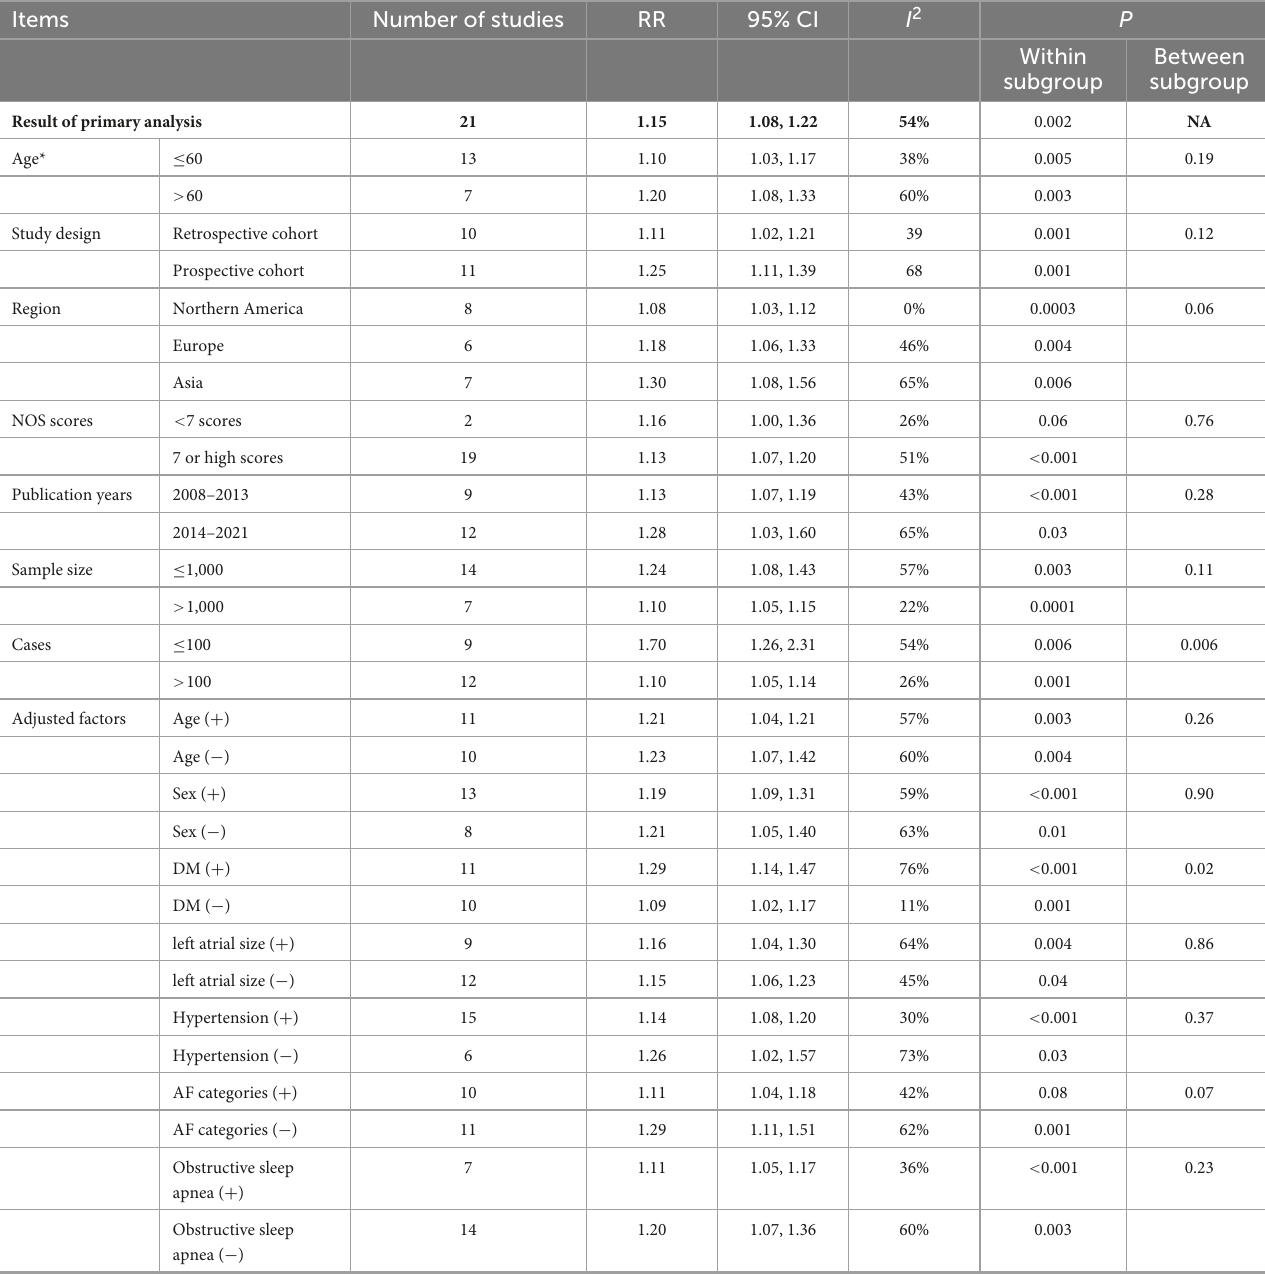
TABLE 2 Subgroup analysis of BMI and AF recurrence in patients after catheter ablation, dose-response analysis, per 5 unit increase. Items Number of studies RR